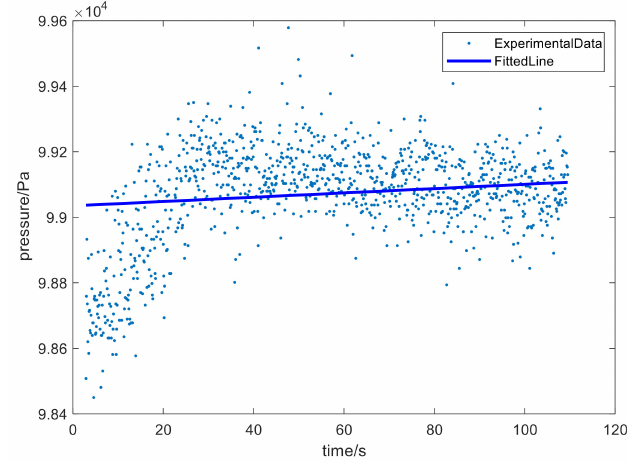
Figure 22. Measured data and fitting curve of pressure sensor 5.